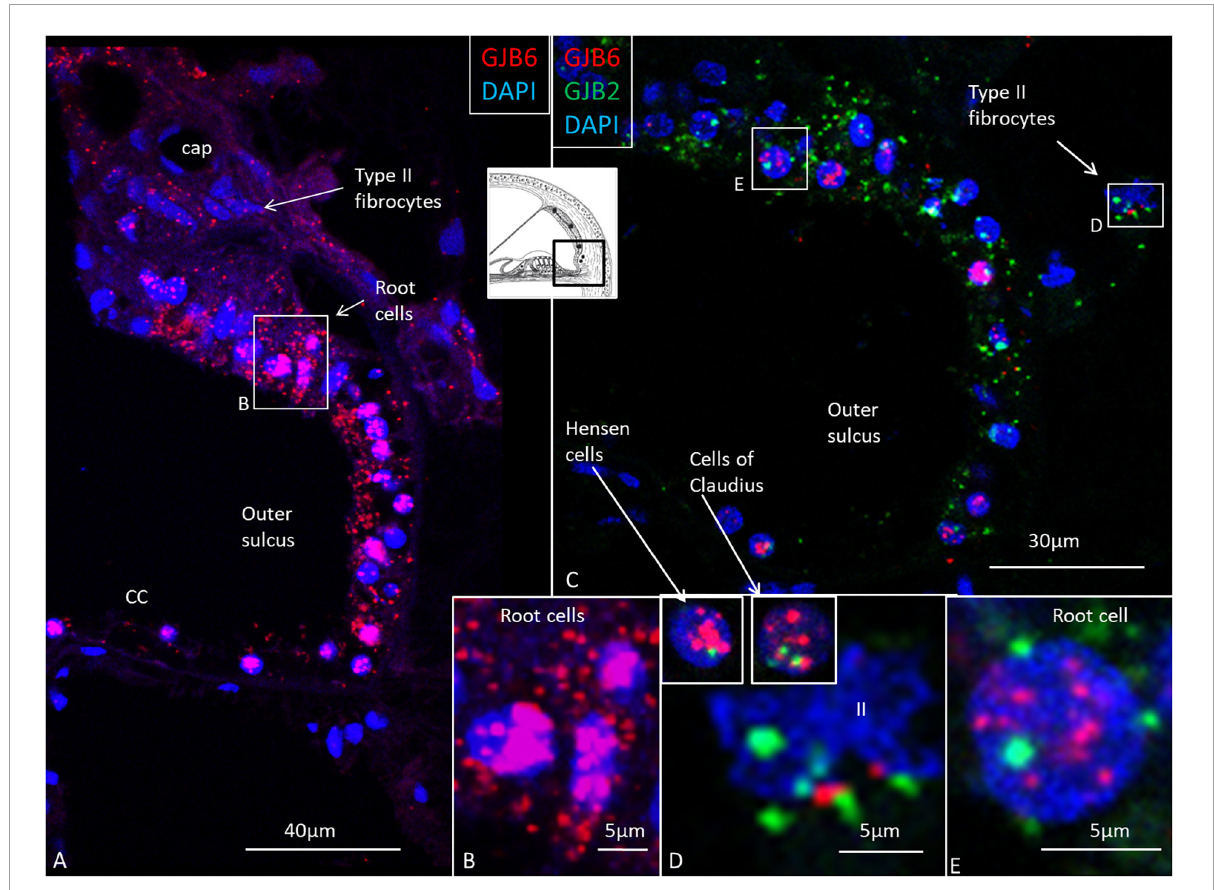
FIGURE8 GJB2 and GJB6 gene transcripts in the outer sulcus in the basal turn of the cochlea. (A) Outer sulcus epithelium and root cells contain a large number of GJB6 transcripts. Type II fibrocytes contain a moderate number of GJB6 transcripts. The framed area is magnified in (B) . (B) Root cell nuclei are crowded with GJB6 gene transcripts. (C) Multiplex RNAscope shows both GJB2 and GJB6 transcripts co-express in the outer sulcus epithelium. Framed areas are magnified in (D,E) , and show both gene transcripts present in a type II fibrocyte (II) and root cell nuclei. Insets in (D) show Hensen and Claudius’s cell nuclei expressing both transcripts, but with GJB6 dominant. The diameter of the cell nuclei is around 5